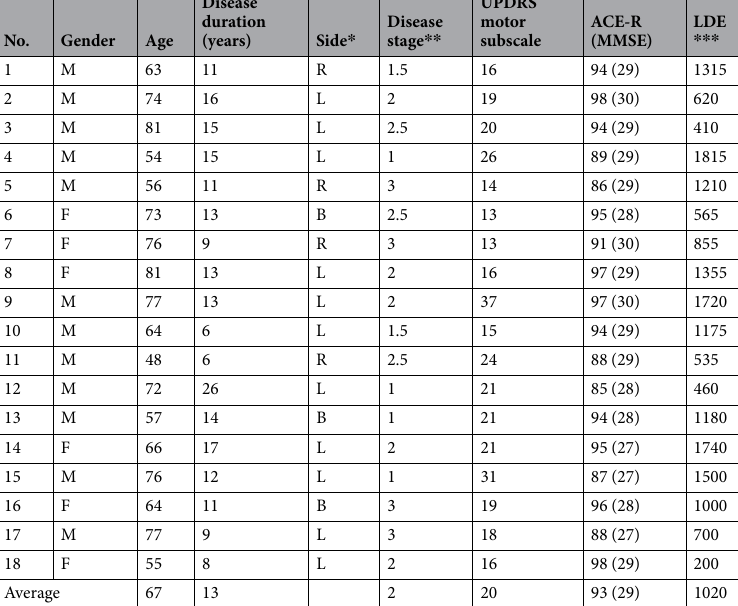
their right index finger to match the force they had just sensed on their left finger (matching period 4.5 sec long). Premature (response during the presentation period) or late ( > 1 s) responses led to a warning “too fast” or “too slow” on the computer screen, and the trial was repeated. Because PD patients have altered force output [e.g. increased force irregularities and time to peak 30 ], the matched force was calculated as the mean force measured within a 500 ms time window that was selected on a trial-by-trial basis. A sliding window was used to identify the 500 ms interval that had the minimum force variability. This procedure was implemented in both patient and control data. There were two conditions. In the Direct condition, participants matched the target force by pressing with their right index finger directly on top of the lever, mechanically transmitting the force to the left finger. In the Slider condition, participants matched the force with their right index finger by moving a slider (a linear poten- tiometer) which controlled the torque motor. A force sensor at the end of the lever measured both the target and matched forces applied to the left finger. All participants performed both the Direct and Slider conditions, in a counterbalanced order. For each condition, an initial familiarisation phase of eight trials (two cycles of the four target forces) was performed. The main experiment for each condition consisted of 32 trials. For each condition, mean force overcompensation was calculated as the average difference between the matched and the target force on each trial across the four target force levels. Positive mean overcompensation in the Direct condition reflected an overall attenuation of self-generated sensations. In the Slider condition, mean overcompensation was used to measure general task-related bias. To examine force matching as a function of force levels, the intercept and slope from a linear regression of matched versus target force was calculated for each participant and condition. The Slider slope was used as a measure of sensory sensitivity for distinguish- ing between the different forces, reflecting sensory precision 19 . All statistical tests of behavioural data were per- formed with two-tailed tests, implemented with ‘R’ software 31 . Given the unequal sample size 32 , non-parametric Mann-Whitney test was used for the comparison between groups. After assessing the normality of errors using Kolmogorov-Smirnoff test, within PD group tests were performed with parametric tests. To examine the rela- tionship between sensory attenuation and clinical variables in the PD group, multiple regression analyses were conducted with Direct force overcompensation as the dependent variables. This variable was used as this measure most closely reflects sensory attenuation 18 ; it does not assume a linear relationship between matched and target force; it has been compared in various population groups 15 ; and it has been associated with fronto-striatal circuits impaired in PD 19 . The independent variables were disease severity and patient LDE. Covariates of no interest were included to account for differences in sensory inflow and motor outflow, namely: Slider slope as a measure of sen- sory sensitivity 19 , mean within-trial force variability and unexplained variance of each patient linear regression of matched versus target force. All variables were Z-scaled before entering the model. Results Participant demographics. Patient clinical information is summarised in Table 1. Patients (n = 18) and controls (n = 175) were not different in terms of age (Mann-Whitney test; Z = 0.92, p = 0.36) and gender ( χ 2 = 1.64, p = 0.2).